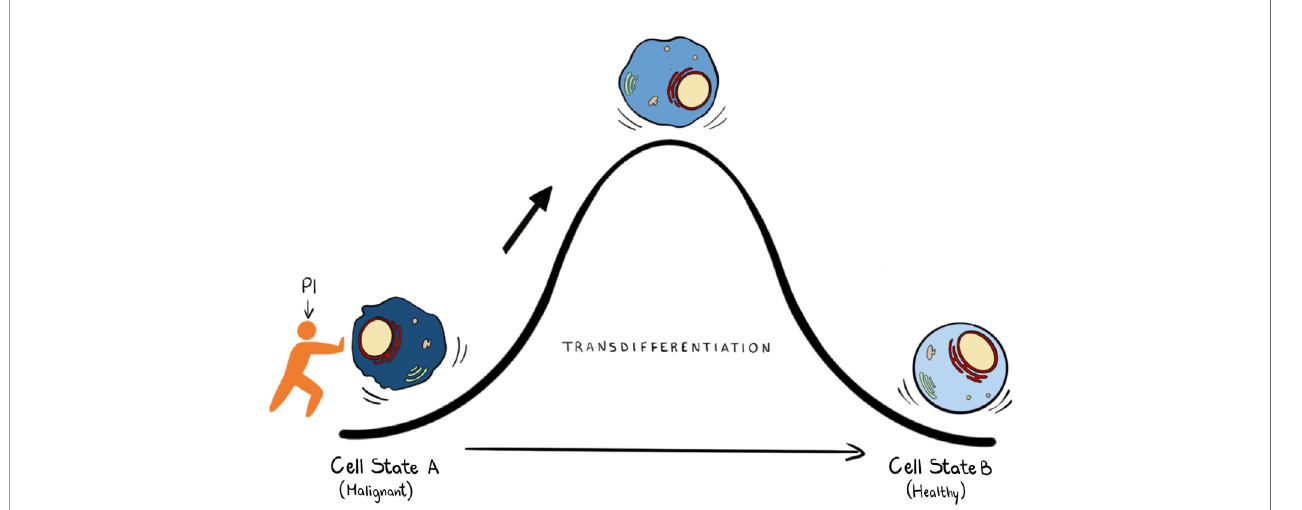
FIGURE 3 | In transdifferentiation a somatic cell can pass from a somatic differentiated change to: this process can be achieved by knowing the transcription factors and the epigenetic regulators that can drive this transition. We propose that PPIns, by being able to regulate epigenetic and transcription factors, could help this